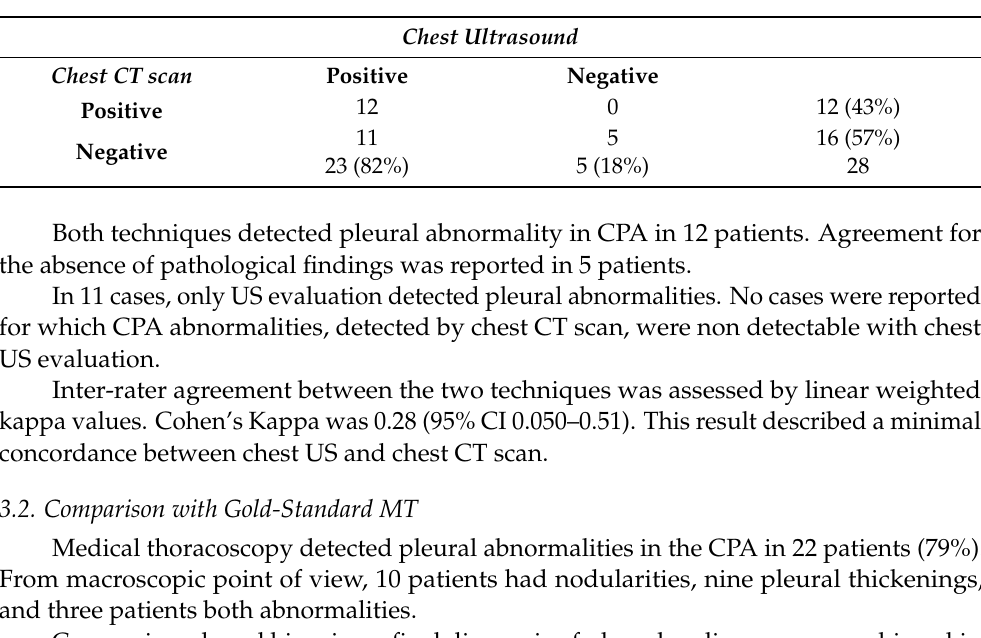
Table 3. Comparison of chest US and chest CT scan findings in CPA.